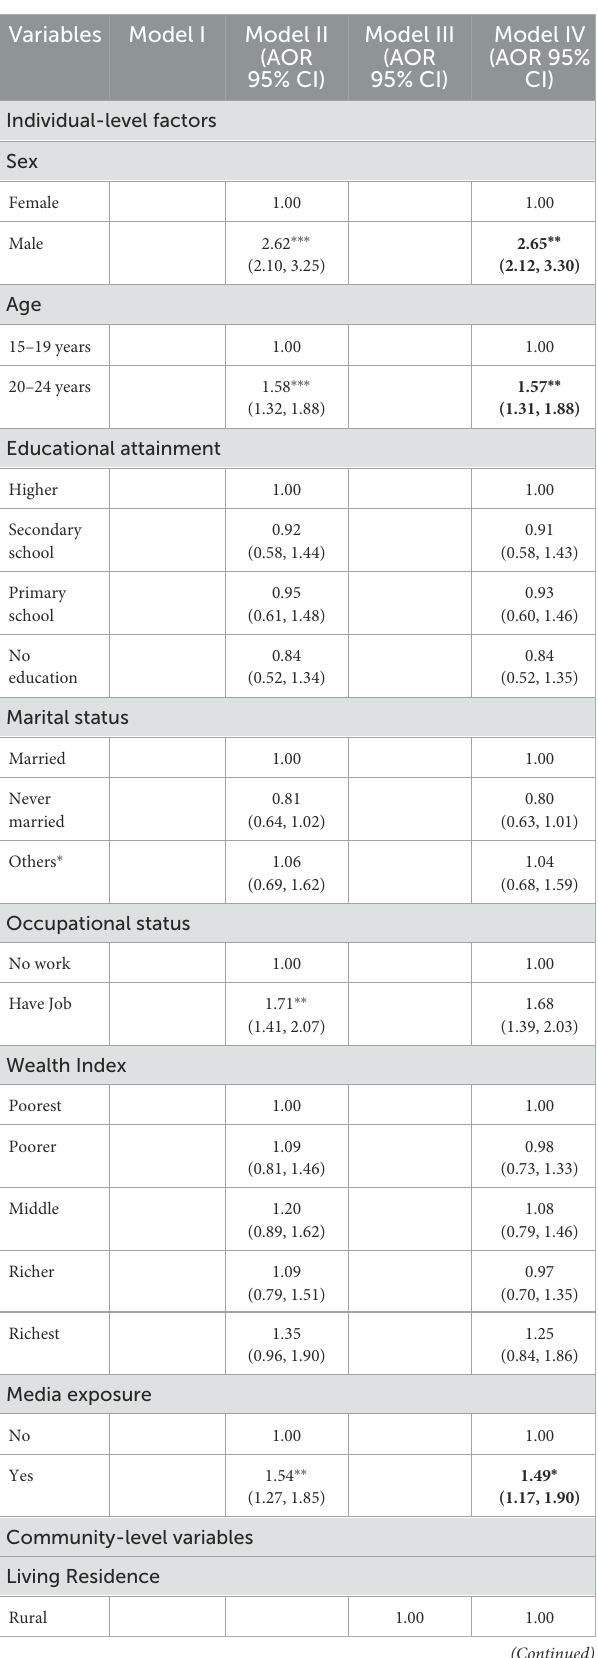
TABLE 4 Multivariable multilevel logistic regression results of both individual- and community-level factors associated with substance use in youth, EDHS